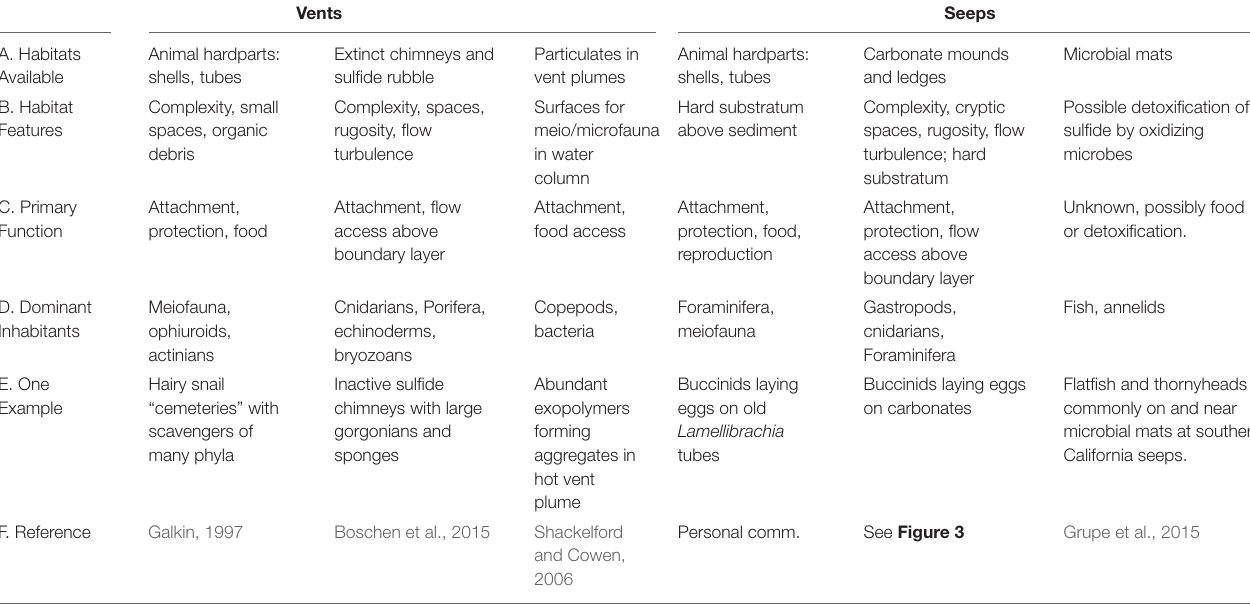
TABLE 1 | Habitats generated by chemosynthetic processes that are used by peripheral and background